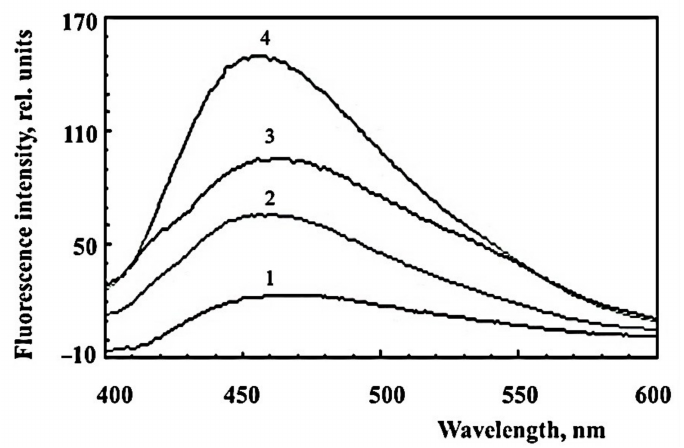
Figure 4. Comparative fluorescence spectra of modified hemoglobin. The incubation medium con- tained 0.1 M sterile K-phosphate buffer, 3 mg/mL bovine erythrocyte hemoglobin, and 3 mM sodium azide. Curve 1—300 µ L of non-irradiated SUPA2E-LB was added; curve 2—300 µ L of irradiated SUPA2E-LB was added; curve 3—50 mM fructose was added; curve 4—4 mM methylglyoxal was added. Samples were incubated at 37 ◦ C for 24 h (for samples with fructose and methylglyoxal) and 48 h (for samples with SUPA2E-LB), and then dialyzed against phosphate buffer for 24